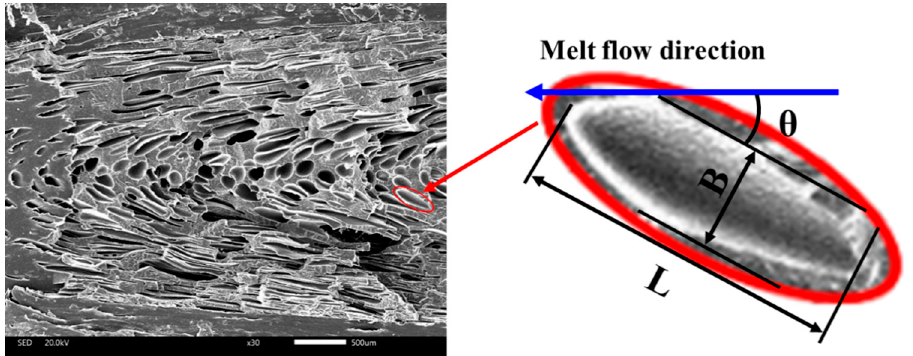
Figure 6. Schematic diagram of ratio of length to diameter and tilt angle.